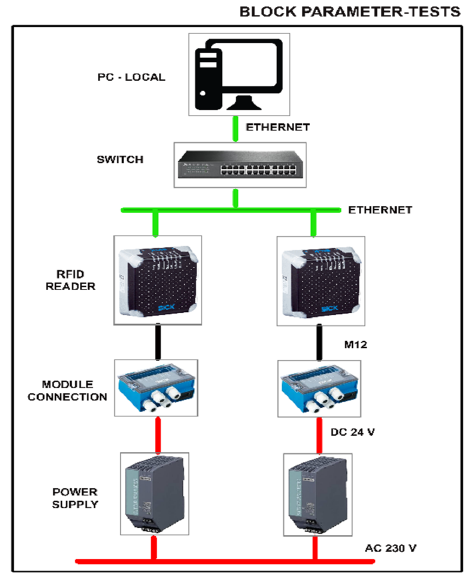
Figure 10. Schematic layout of RFID-System used in the Block-Parameter Tests.